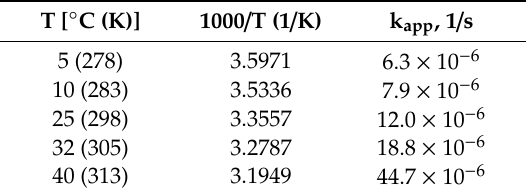
Table 1. Value of each apparent kinetics constant for the five temperatures